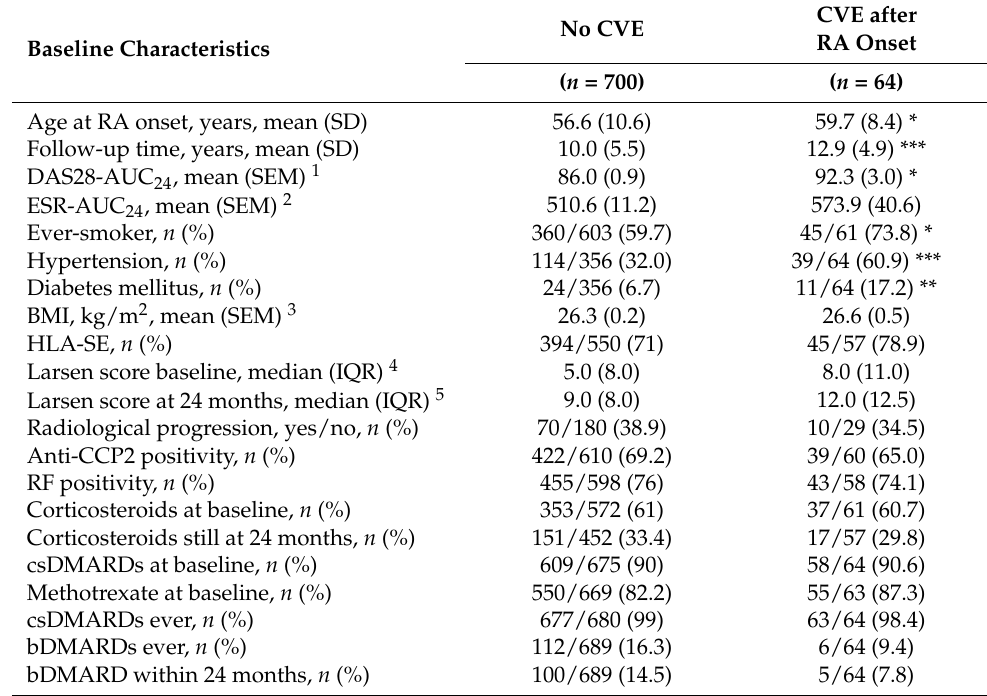
Table 1. Baseline characteristics of RA patients without CVE and CVE after RA